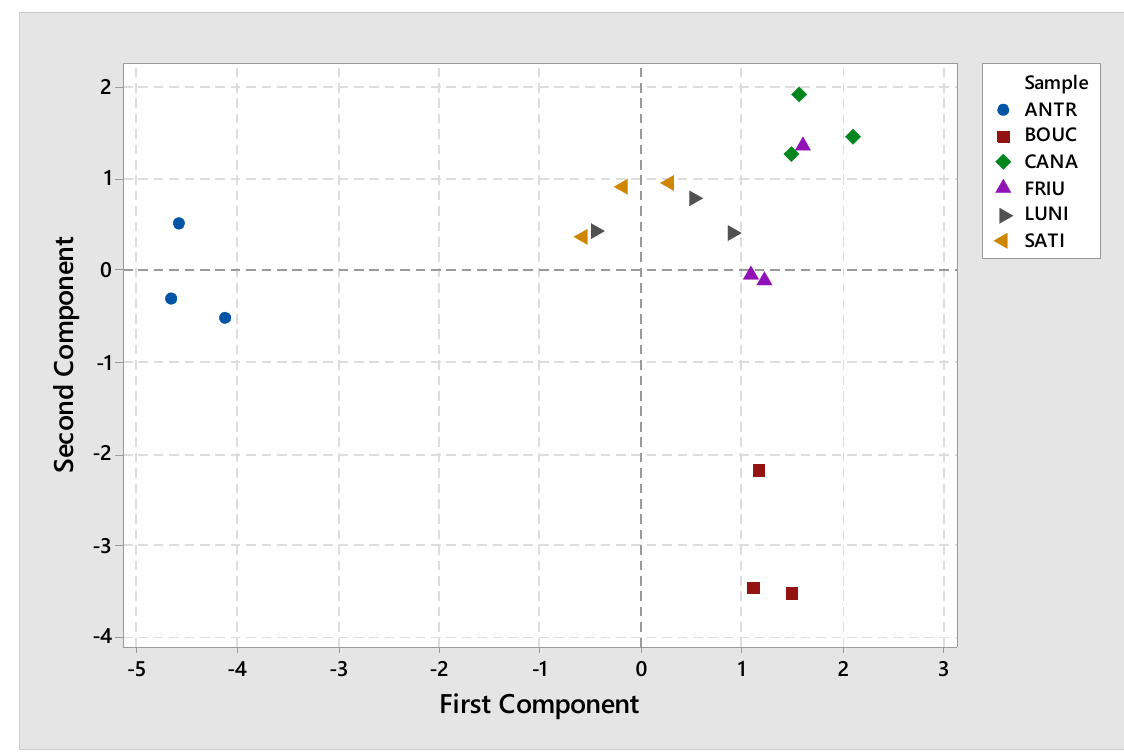
Figure 5. Principal component analysis (PCA_1) score plot of tested CFs. Mean values (n = 3) were included for each sample. Flour IDs were reported in Table 1.